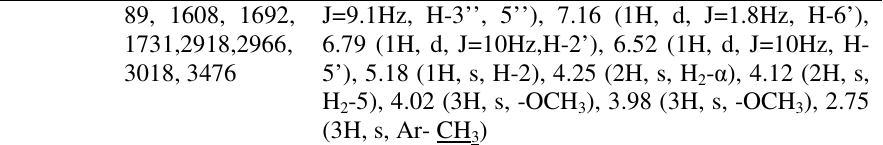
Table 3 . Zone of Inhibition of Compounds [4